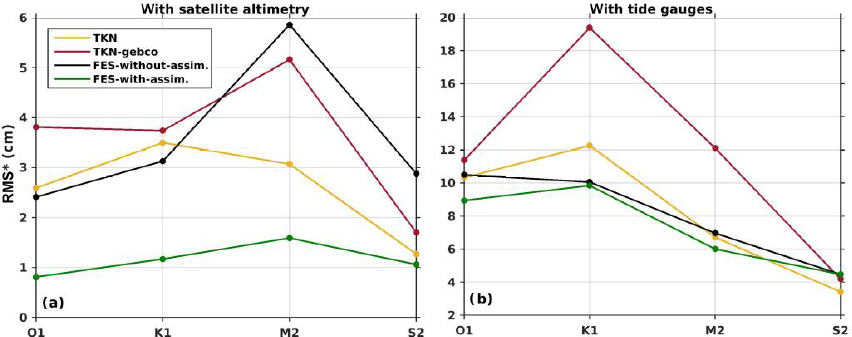
Figure 16. RMS ∗ errors (Appendix; Eq. A2) between numerical simulations (TKN, TKN-gebco, FES2014b-without-assimilation, and FES2014b-with-assimilation) and (a) altimetry data and (b) tide gauges for O 1 , K 1 , S 2 , and M 2